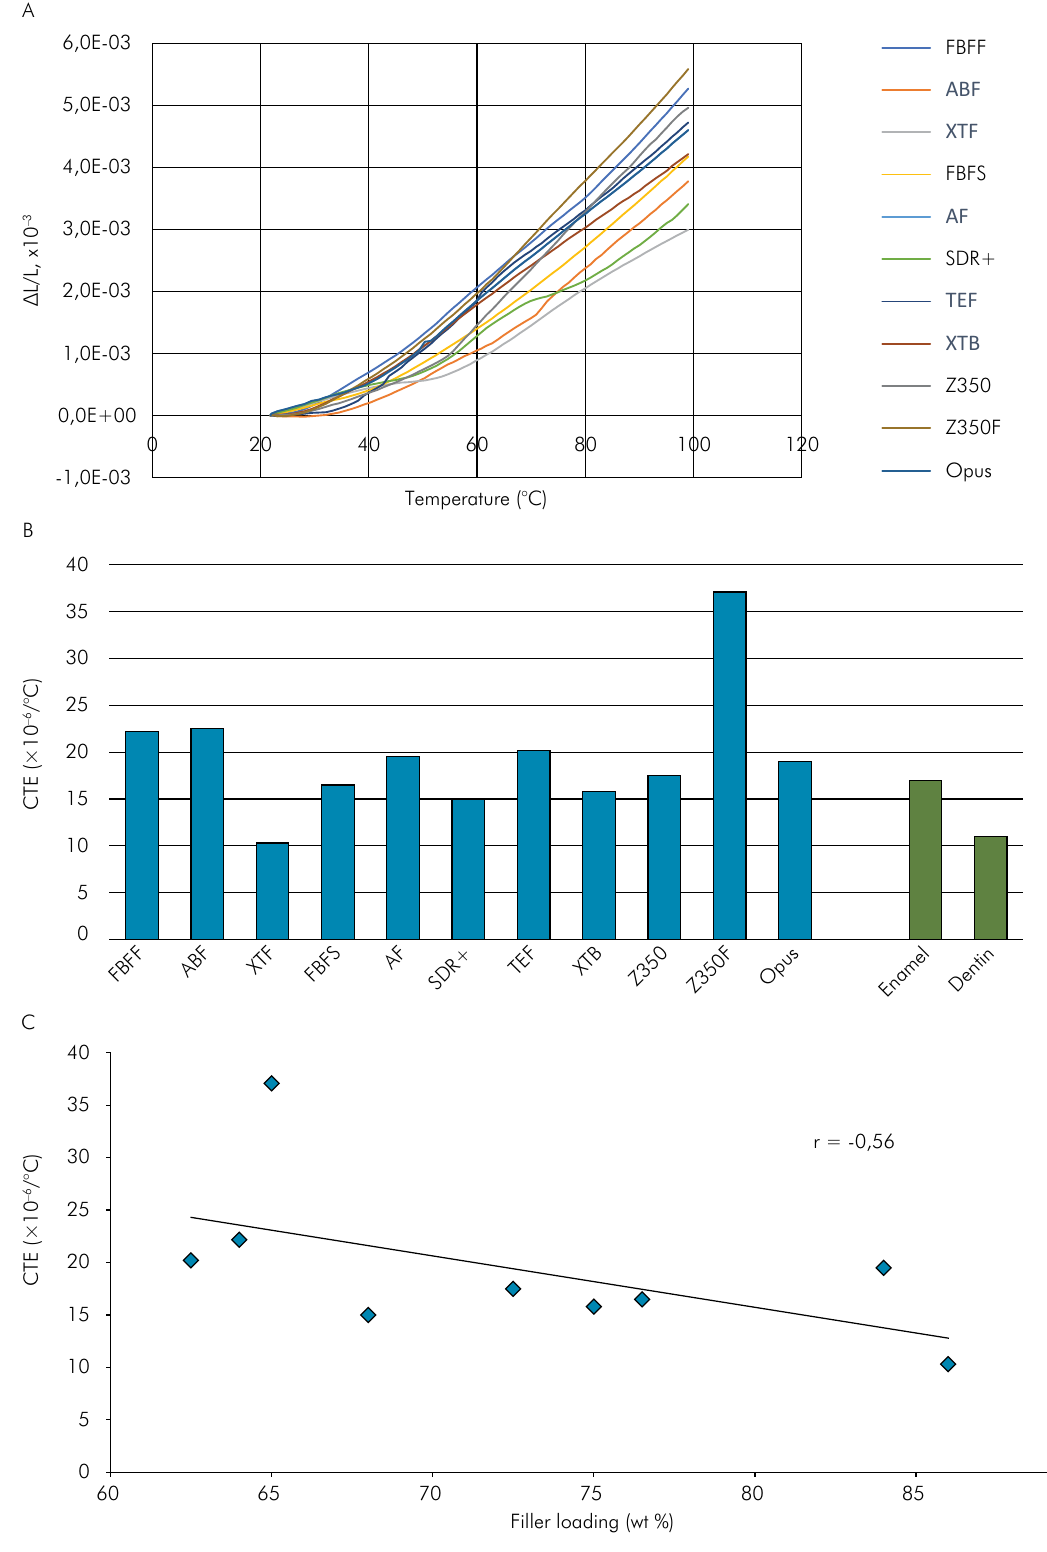
Figure 3. (A) Relative dimensional variation ( Δ L/L) of composite resin, (B) thermal expansion, (C) linear correlation between CTE and filler loading of the dental